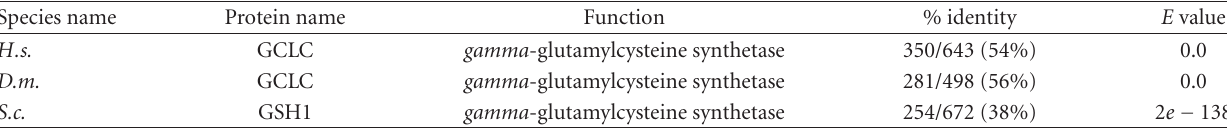
Table 1: Similarity between C . e gamma -glutamylcysteine synthetase and orthologues in H.s., S.c., and D.m .